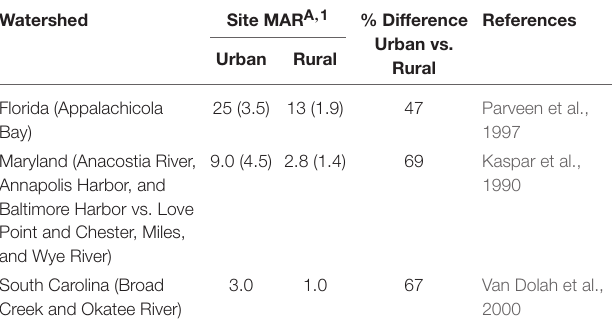
TABLE 5 | Comparison of antibiotic resistance in E. coli bacteria at different coastal geographical locations in Maryland, South Carolina, and Florida.